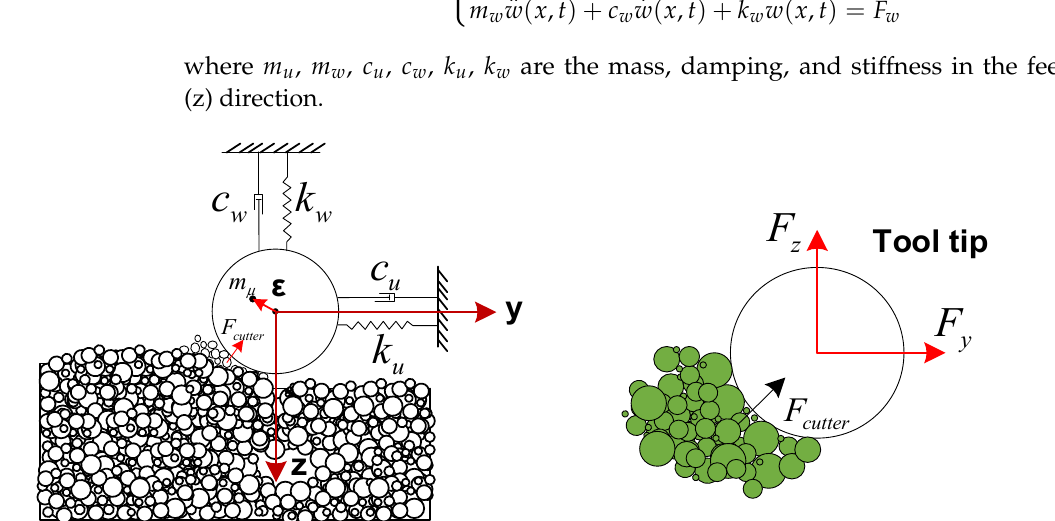
Figure 1. Two-degree freedom system of micro end milling